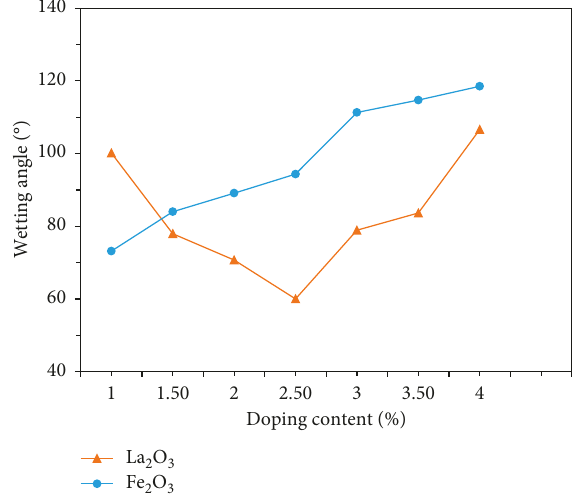
Figure 3: The wetting angle under different proportion of additives. Table 1: Additive content of Ag-SnO Ingredient